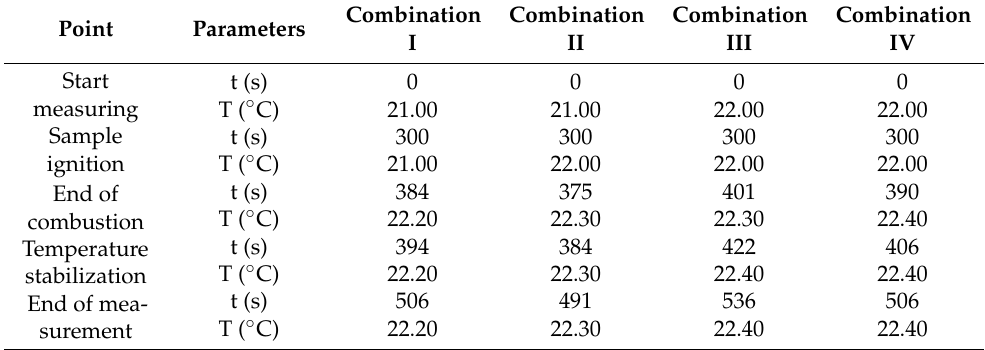
Table 2. Characteristic temperature points of fir sawdust combustion.